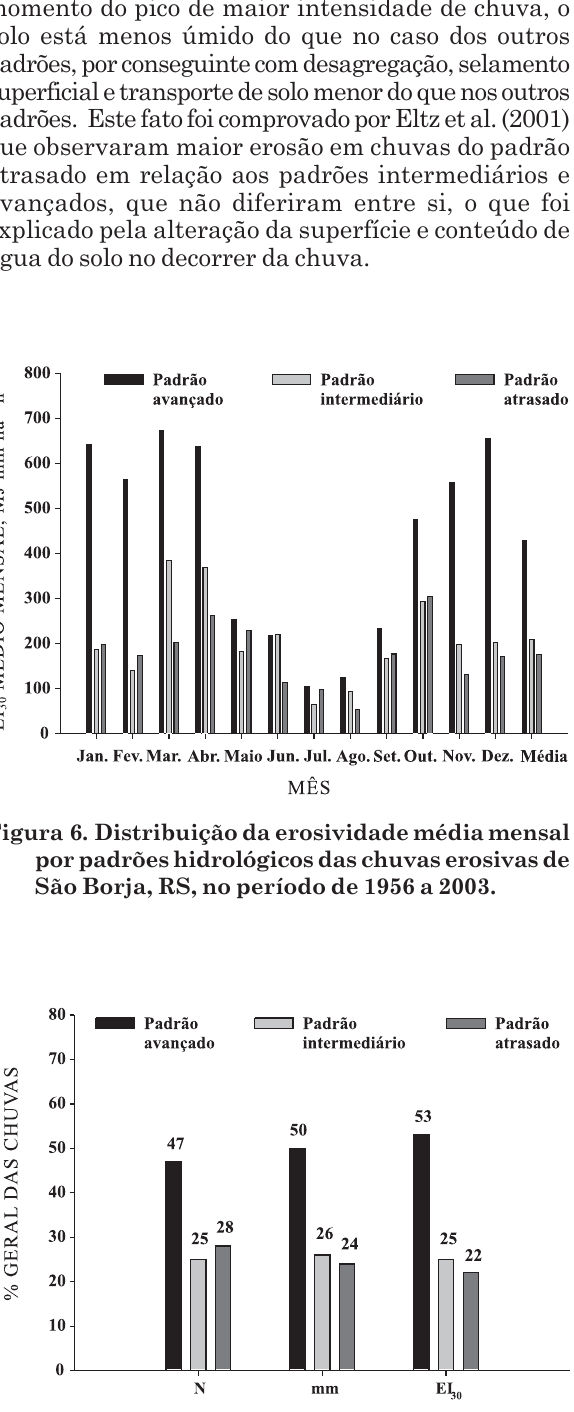
Figura 7. Distribuição percentual média geral do número (N), quantidade (mm) e erosividade ) das chuvas de São Borja, RS, por padrões (EI 30 hidrológicos, no período de 1956 a 2003.